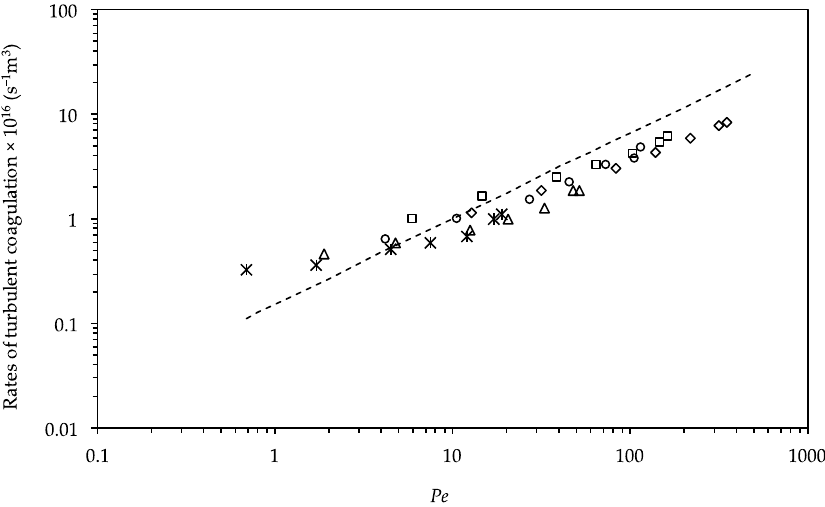
Figure 7. Data in Figure 5 replotted as a function of Peclet number. Symbols are the same as those in Figure 6. The dashed line indicates theoretically predicted values. Figure 6. The dashed line indicates theoretically predicted